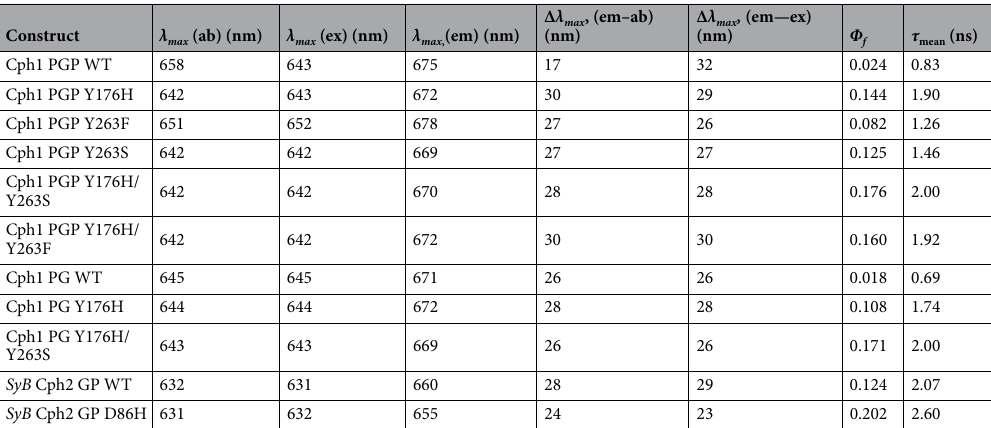
Table 1. Spectroscopic properties of Cph1 PGP, Cph1 PG, SyB-Cph2 GP and their variants as shown in Figs. 2, 3 and 4. Table S2 provides the detailed results for the fluorescence lifetime fits including an exhaustive error analysis. The fluorescence quantum yield Φ f is given as